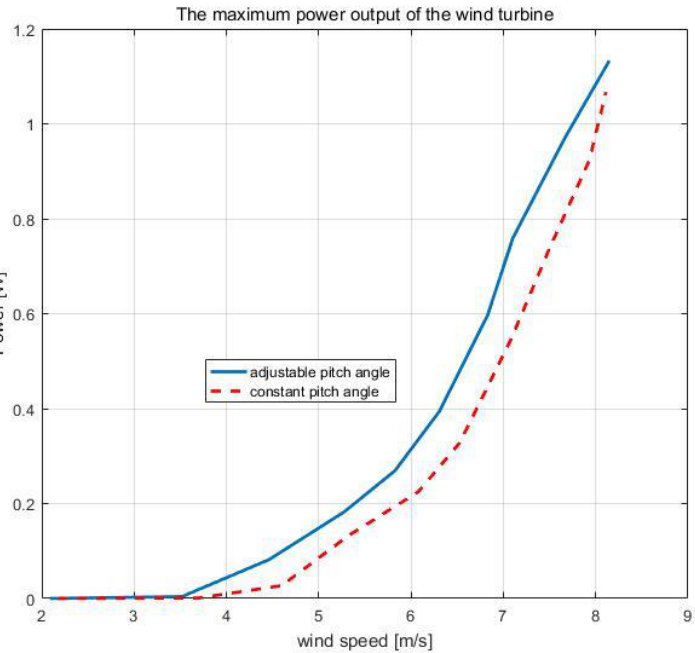
Figure 16. The maximum power of a wind microturbine for the case of constant and adjustable pitch.